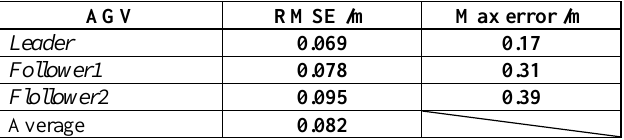
Table 1 . The RMSE and Maximum error of position for